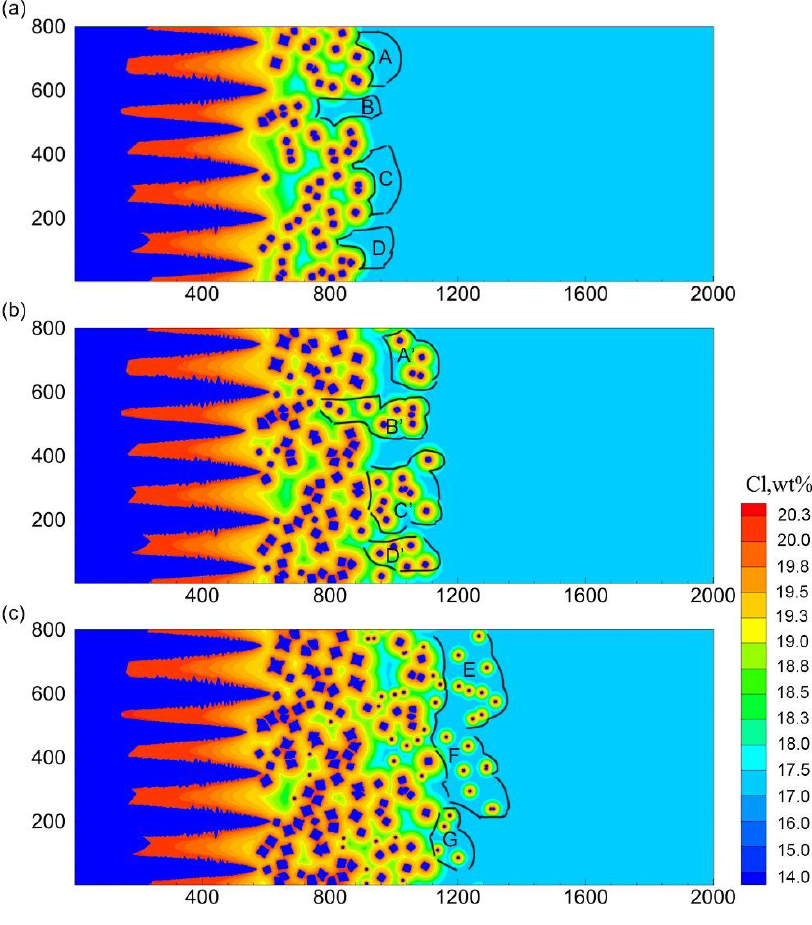
Figure 8. The solute field during the dendrite growth process when the undercooling of the crystal nucleus generator is 300 K. The solidification time from ( a )–( c ) is 7.2, 7.5, and 7.8 s, respectively.